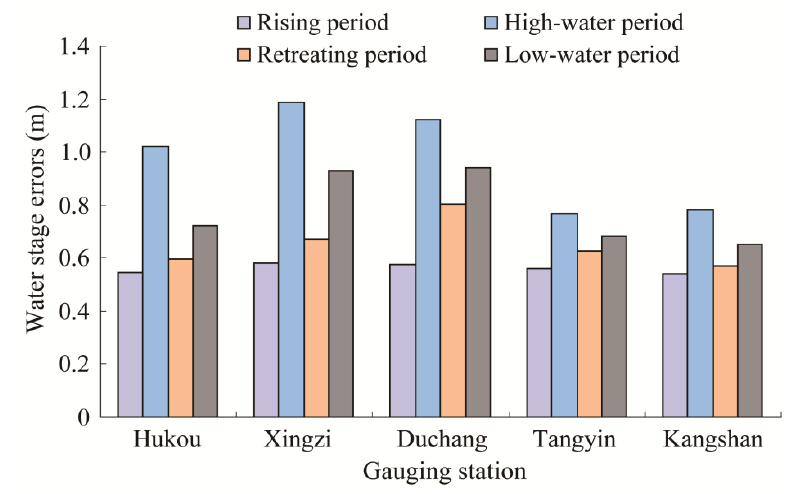
Figure 4. Mean absolute bias error of water level between MODIS-derived and gauge station measurements during different water